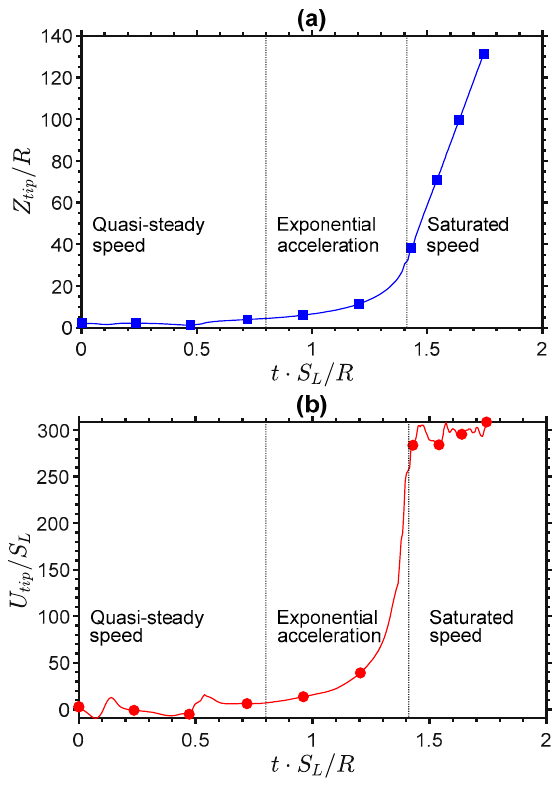
Figure 3. The scaled flame tip position Z tip / R ( a ) and velocity U tip / S L ( b ) versus the scaled time τ = tS L / R for a flame with the expansion ratio Θ = 8 in a channel with the blockage ratio α = 1/2.